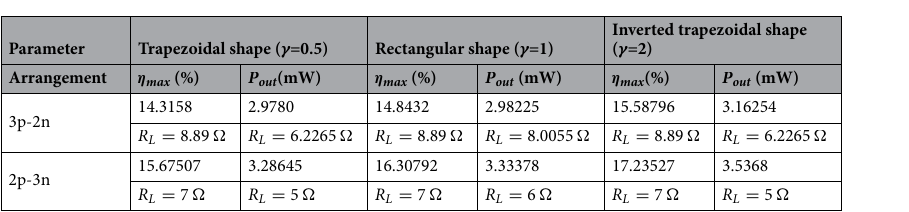
Table 3. Comparison of maximum values of efficiency and output power at (cid:31) T=600 K.